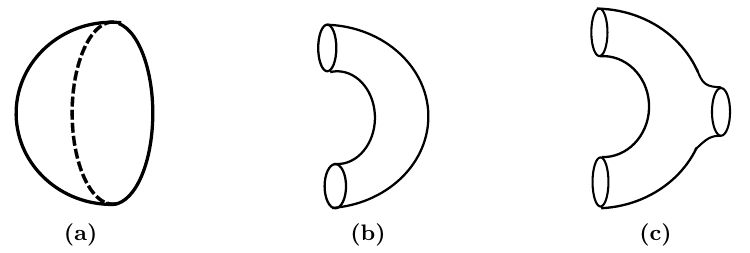
Figure 1. ( a ) The identity of the Frobenius algebra V N;M corresponds to a sphere with an out- boundary (right boundary). ( b ): the Frobenius form (cid:17) : V N;M (cid:10)V N;M ! R corresponds to a annulus with two in-boundaries (left boundaries). ( c ): the product (cid:3) : V N;M (cid:10) V N;M ! V N;M corresponds to a pant with two in-boundaries and an